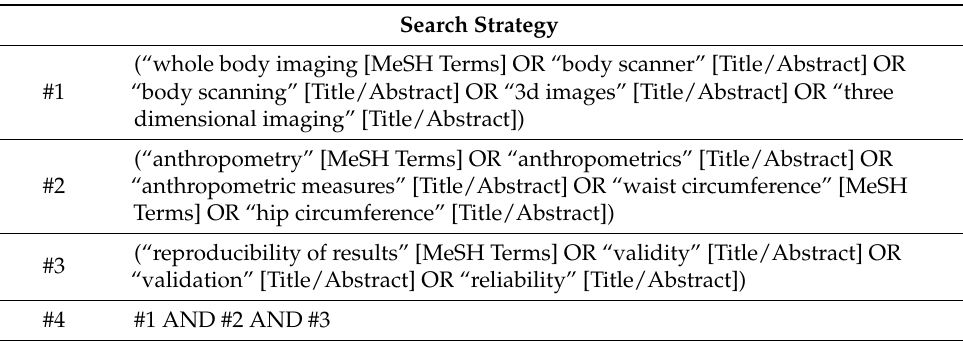
Table 1. PubMed search